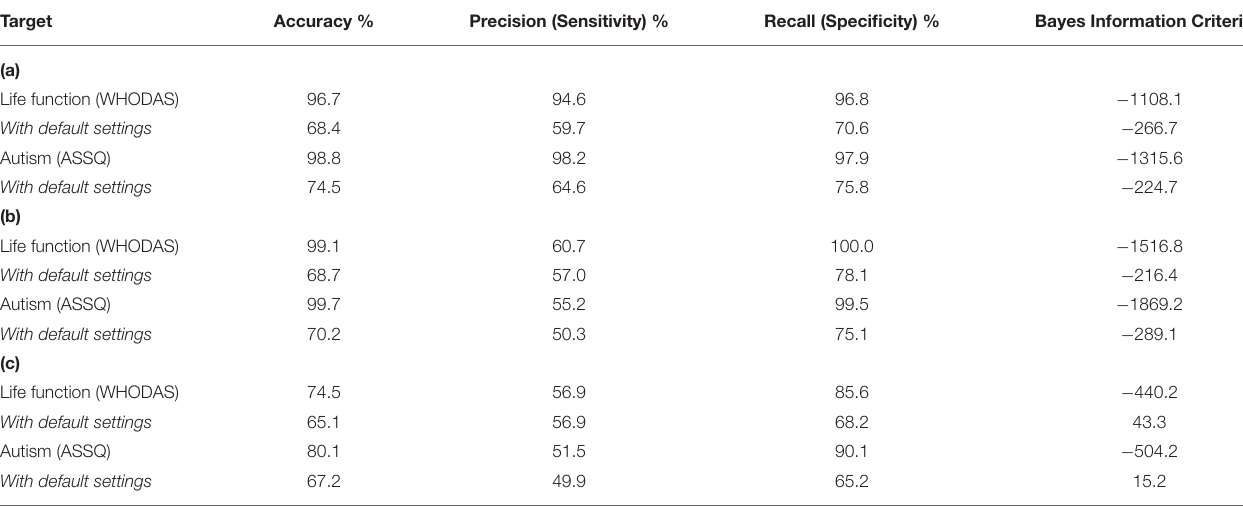
TABLE 3 | Results of classification using 3 algorithm types optimized with IEL vs. default settings.